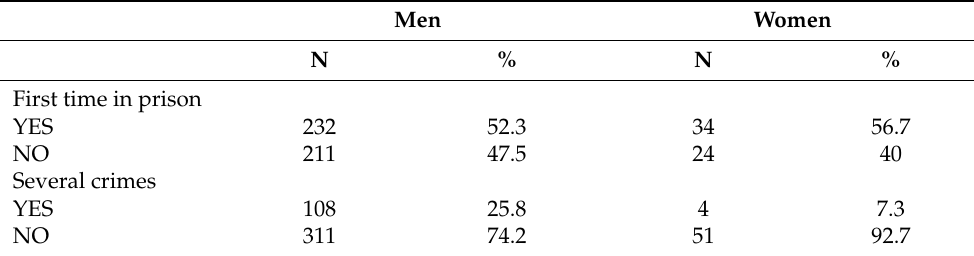
Table 1. Descriptive statistics of the sample based on criminal